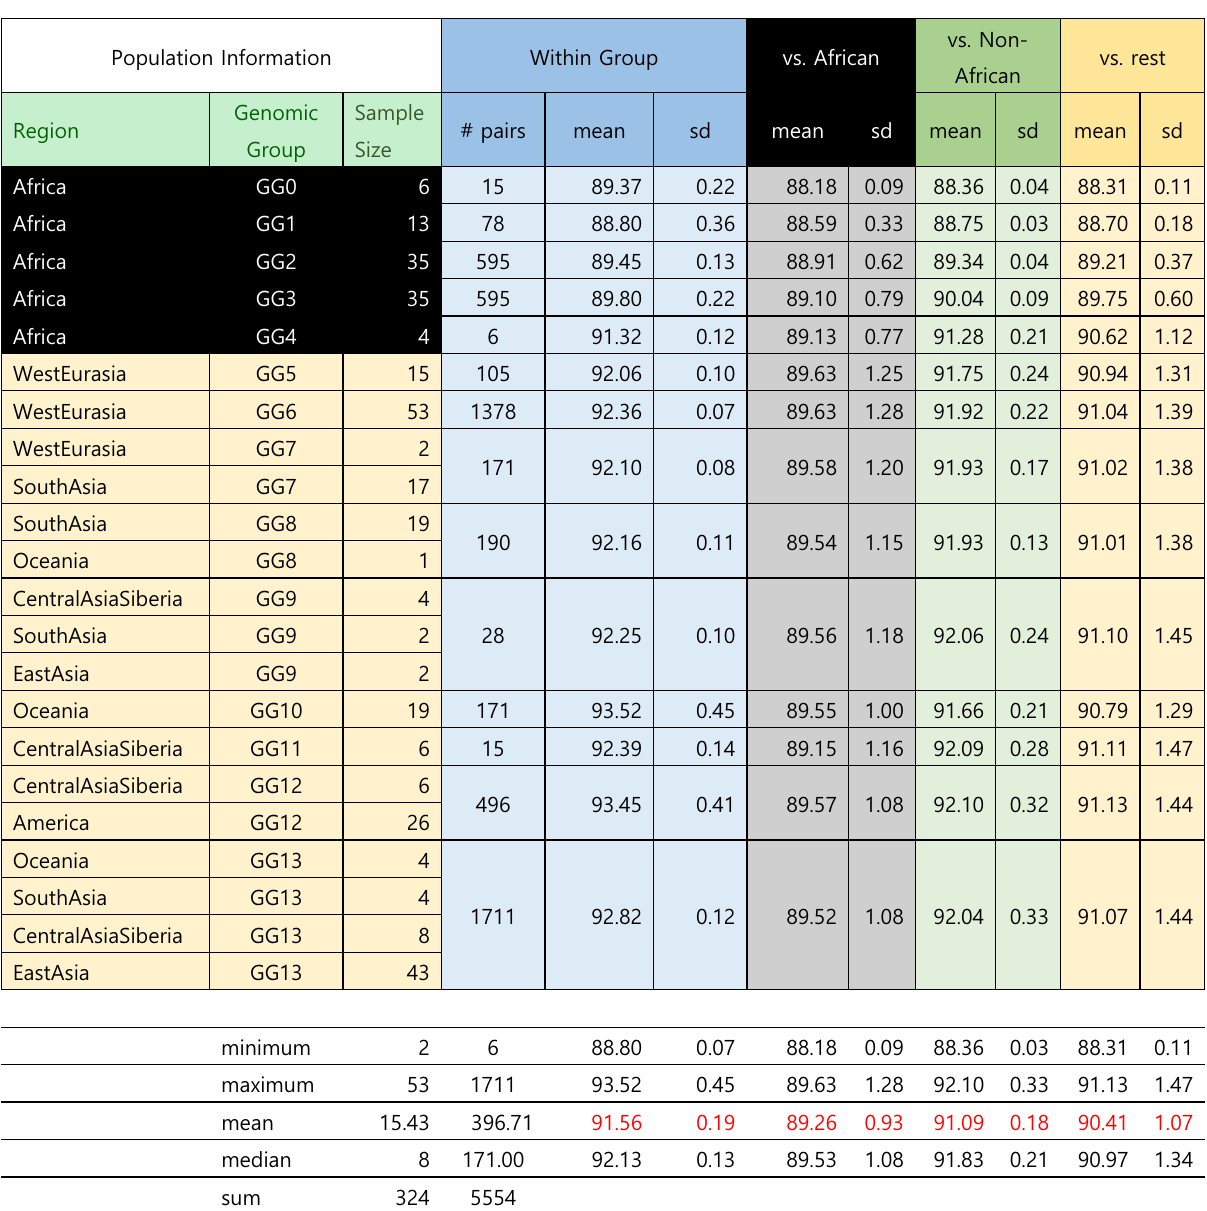
Figure 4. Average genotype identity in % of whole-genome SNP loci between two individuals. ( A ) Average % SNV genotype identity between two individuals within each “population group” (PG) of the 1KGP population in column 1 and each of four categories on row 1. The numbers of pairs compared, average % SNV genotype identity, and standard deviations (SDs) are listed. Also listed are the minima, maxima, means, medians, and sums of sample sizes. ( B ) Average % SNV genotype identity of the SGDP samples between two individuals within each GG in column 1 and each GG category on row 1. Also listed are the minima, maxima, means, medians, and sums of sample